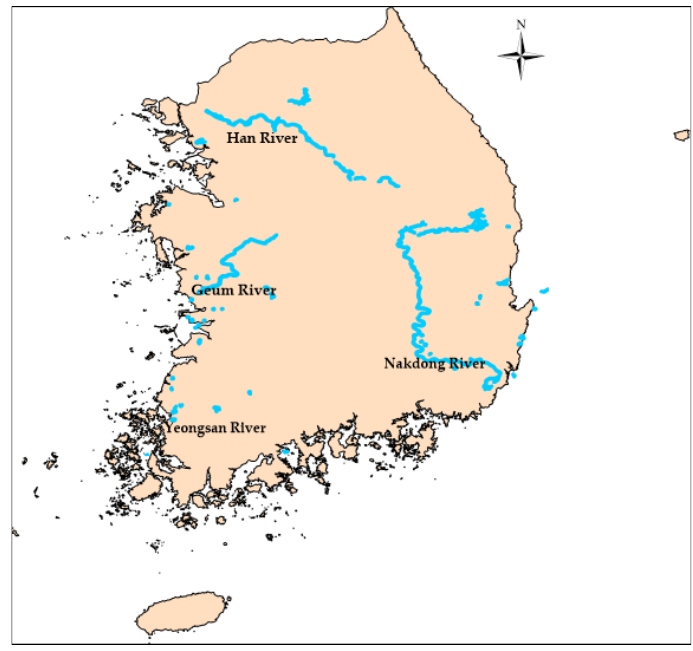
Figure 1. Map showing South Korea’s water resources.